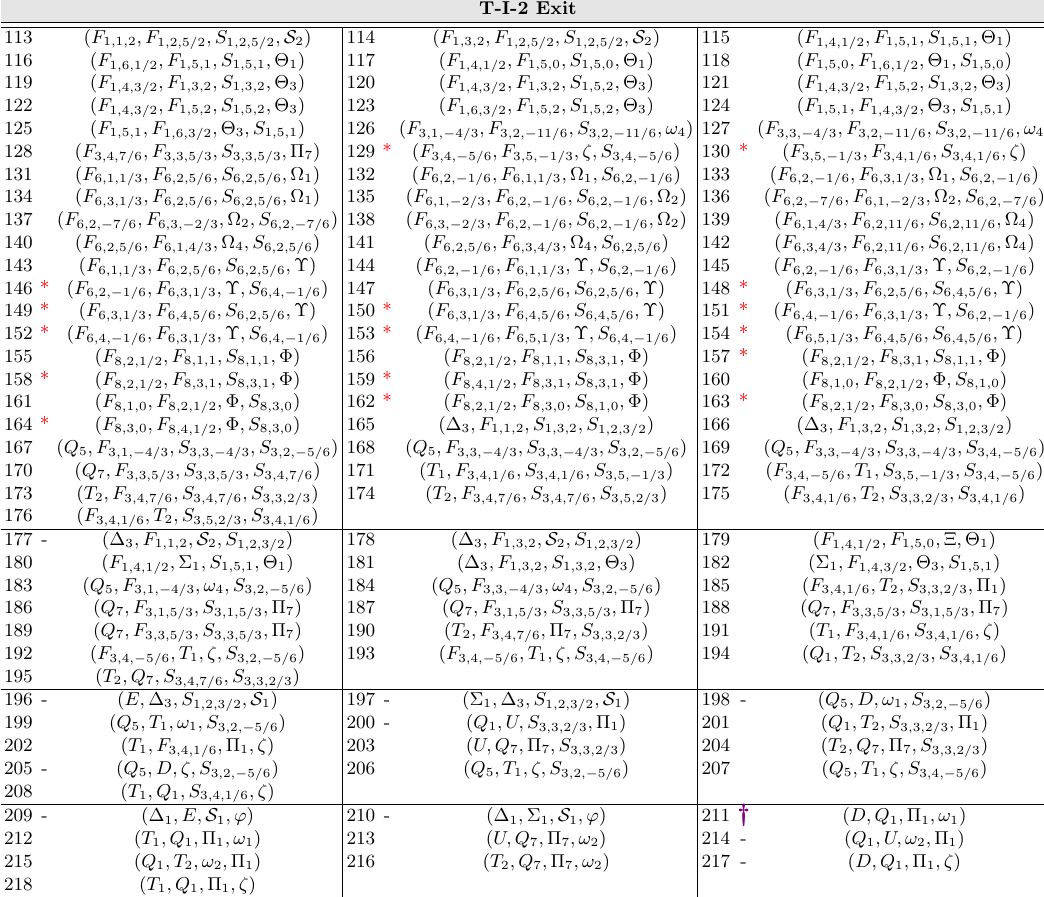
unifies at a scale of m G = 10 17 GeV . †